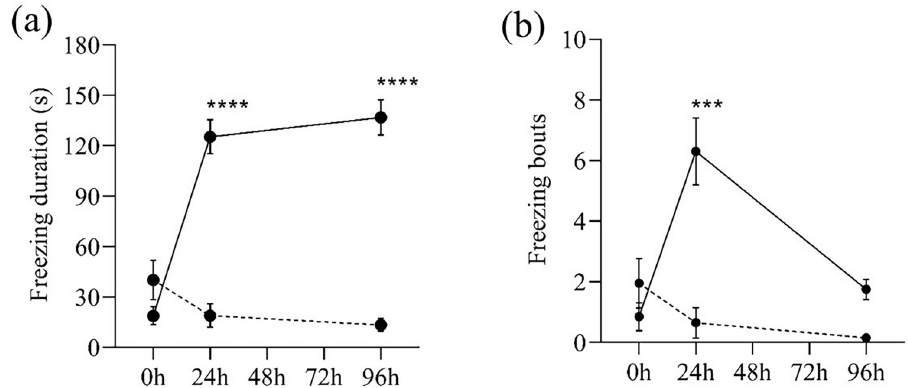
Fig 5. Freezing maintenance of MPTP-injected (solid lines) and control (dashed lines) zebrafish. (a) Freezing duration (in sec) and (b) Number of freezing bouts during the three-minute behaviour test. Two-way RM ANOVA revealed that there were statistically significant interactions between the effects of MPTP injection and time on the freezing maintenance (duration: [F (2,76) = 42.54, p < 0.0001], bouts: [(F (2,76) = 15.46, p < 0.0001)]. Post-hoc Tukey’s test found that the mean freezing duration of MPTP-injected group were significantly different between 0h and 24h (p < 0.0001, 95% CI = [-133.30, -79.69]), and between 0h and 96h (p < 0.0001, 95% CI = [-147.00, -89.10]). Meanwhile, the mean number of freezing bouts of MPTP-injected group was significantly different between 0h and 24h (p = 0.0003, 95% CI = [-8.248, -2.652]). All values are presented as mean and error bars represent the SEM. n = 20 per group. ��� p < 0.001, ���� p < 0.0001.